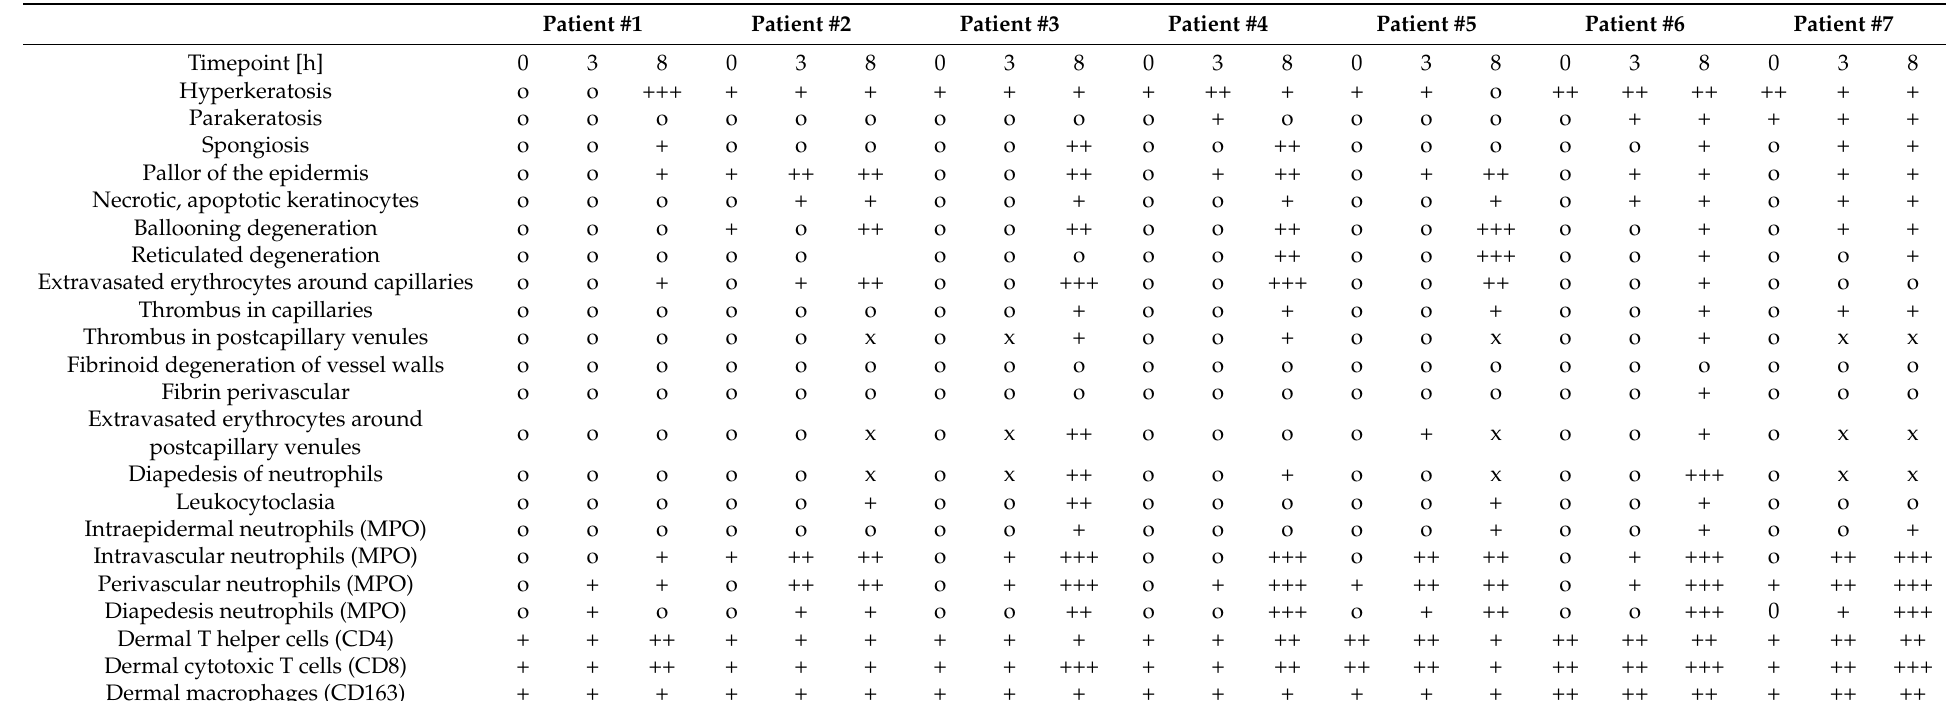
Table 1. Histomorphological and immunohistochemical